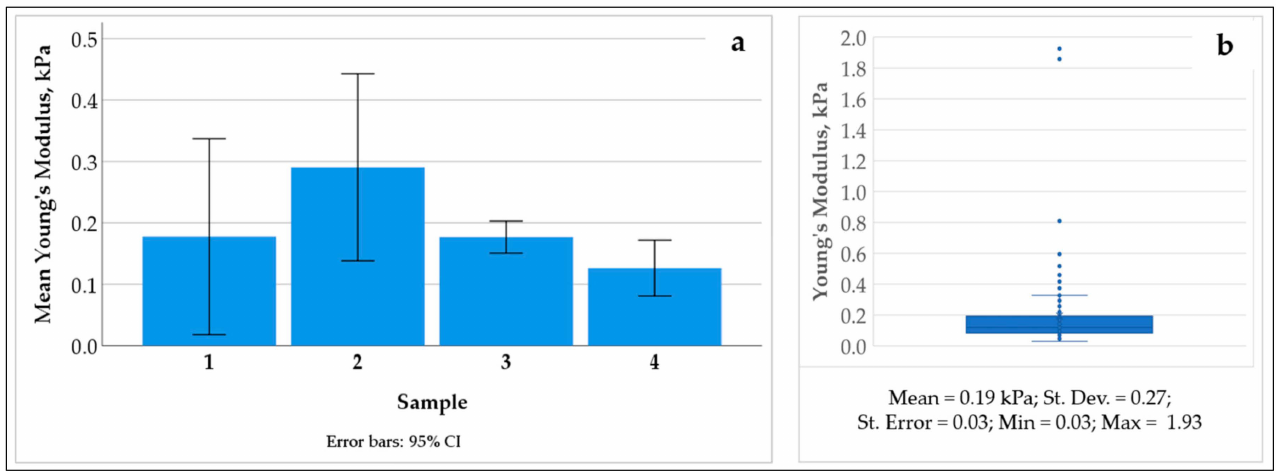
Figure A6. Mechanical characterization of the LS-ECM in hydrated state. Peak force mapping illustrates the distribution of the mean Young’s modulus across four samples of CE liver AOSSs ( a ) and overall distribution of the values in the whole set of samples (the dots show the individual values emerged beyond the 25%–75% interquartile range) ( b